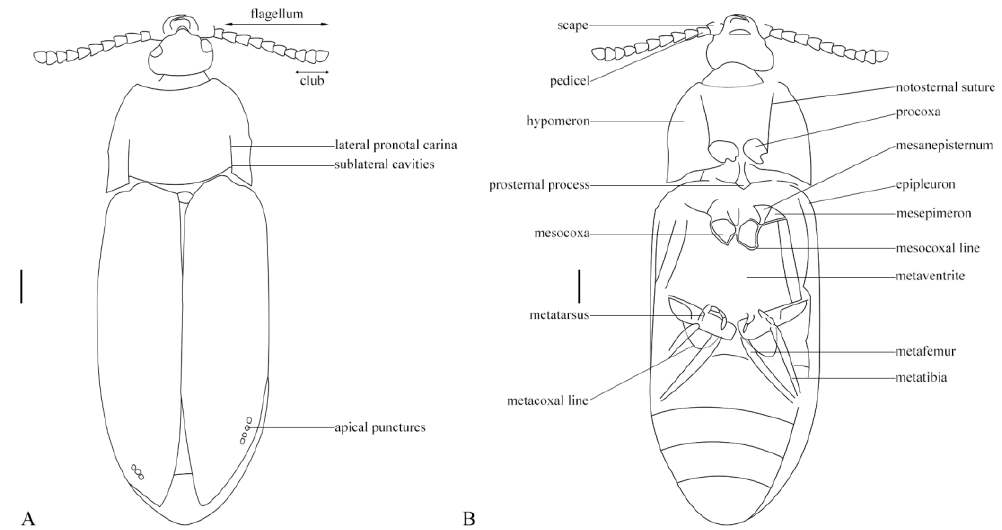
Figure 2. Rheanischia brevicornis n.sp. Holotype. Drawing. (2018344). ( A ) Dorsal view, ( B ), ventral view.